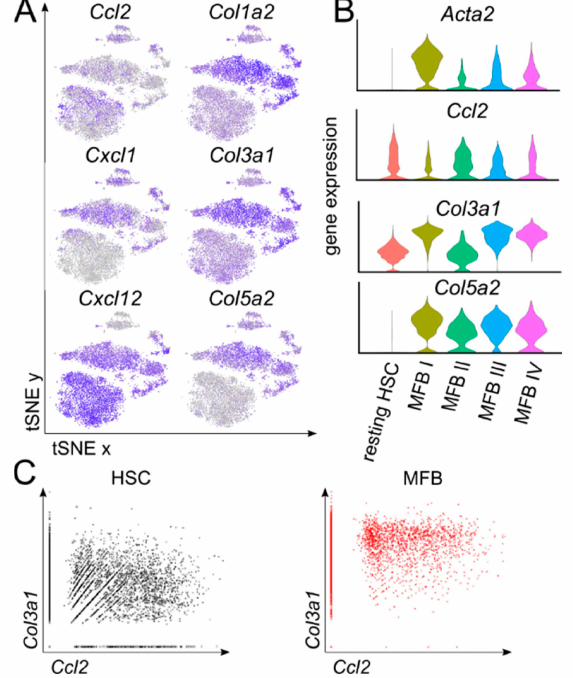
Figure 3. Di ff erential chemokine and collagen gene expression patterns in hepatic stellate cells and myofibroblasts. ( A ) Feature plots showing the relative gene expression strength of selected marker genes. ( B ) Violin plots showing the relative gene expression of activation markers. ( C ) Gene plots for the normalized gene expression of Col3a1 and Ccl2 . n = 4 with an average of 5000 cells per condition and ~60,000 reads per